Question: What form of chart is displayed?
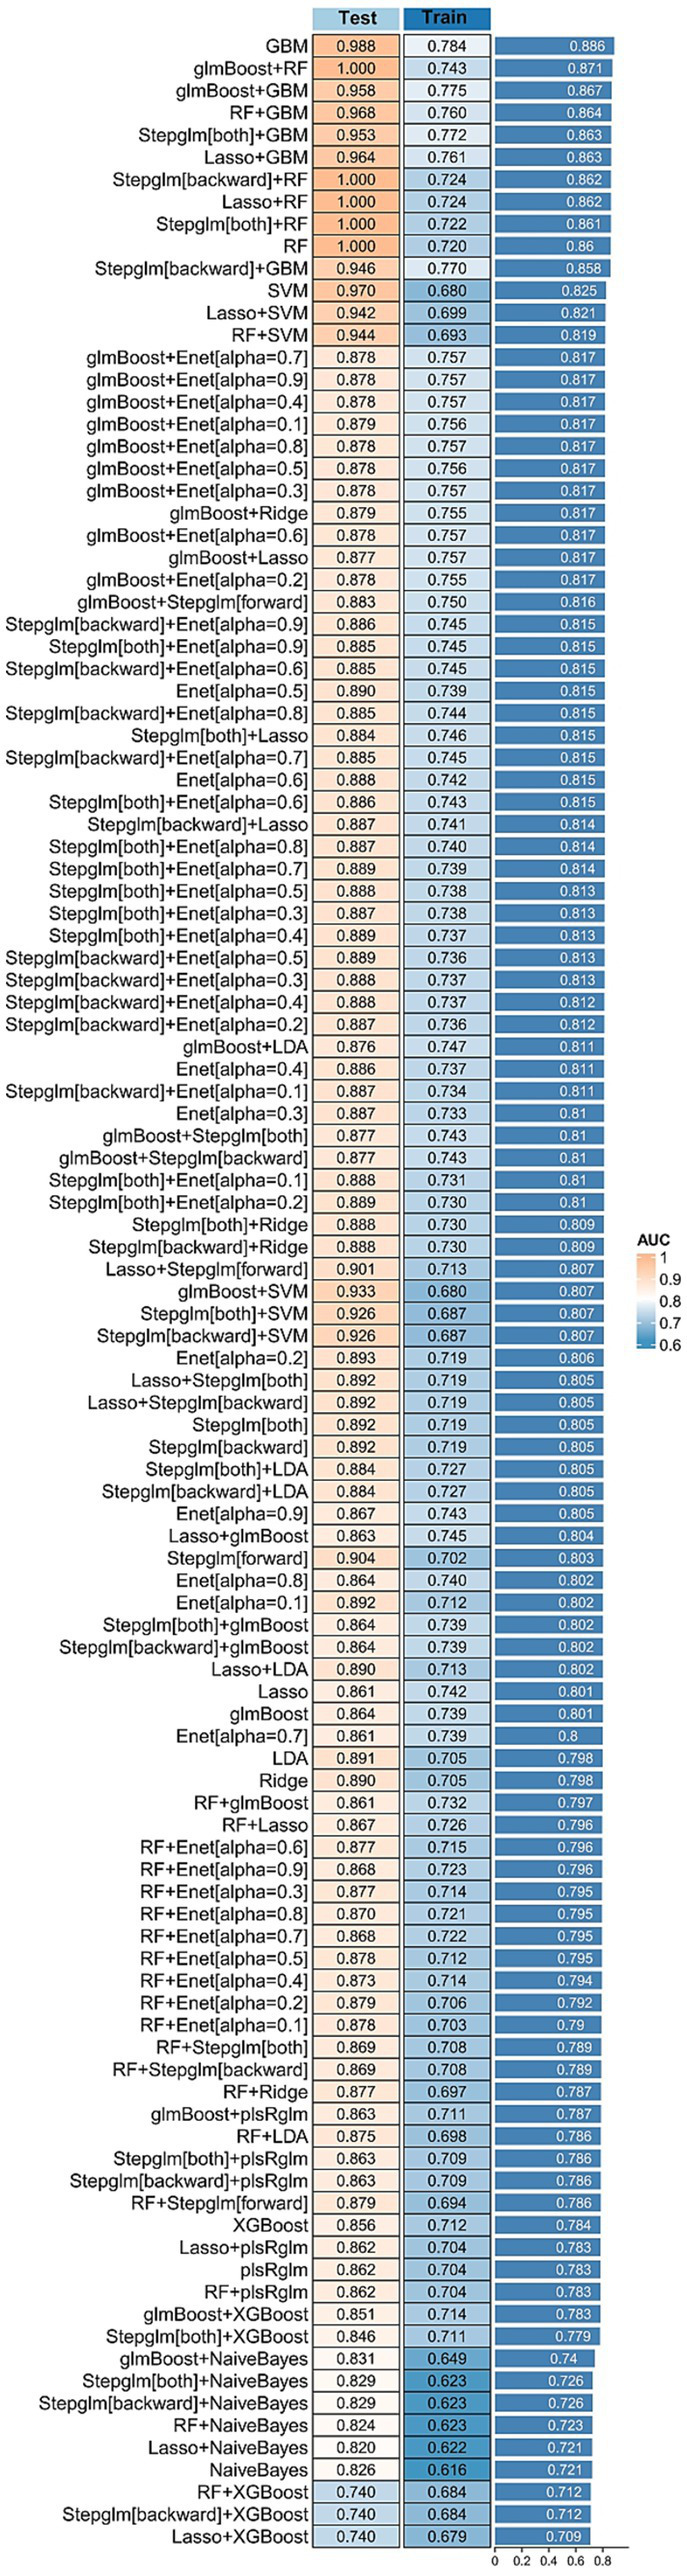
Answer: bar